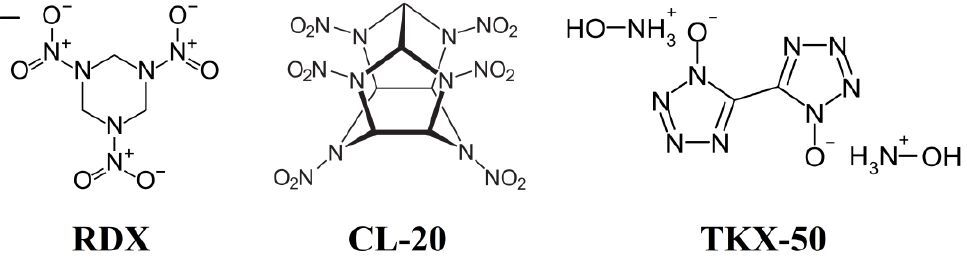
Figure 1. Chemical structural formulas of RDX, CL-20, and TKX-50. Table 1. Compositions of test